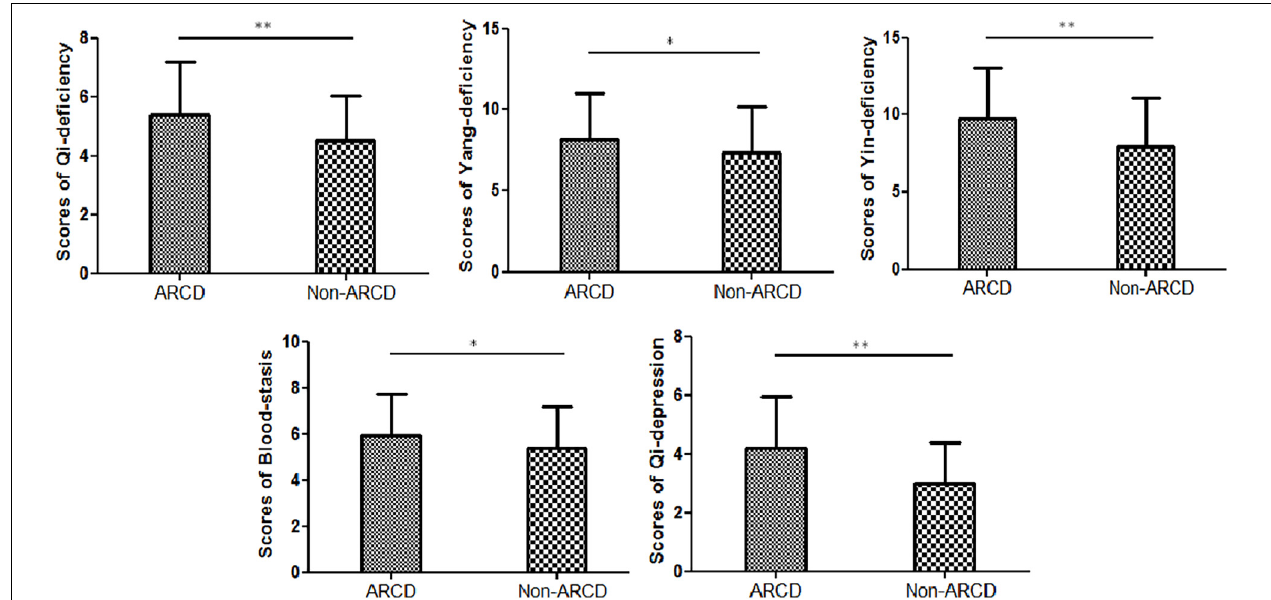
FIGURE 1 | Traditional Chinese Medicine (TCM) constitution of centenarians with and without age-related cognitive decline (ARCD). ∗∗ p < 0.01; ∗ p < 0.05.